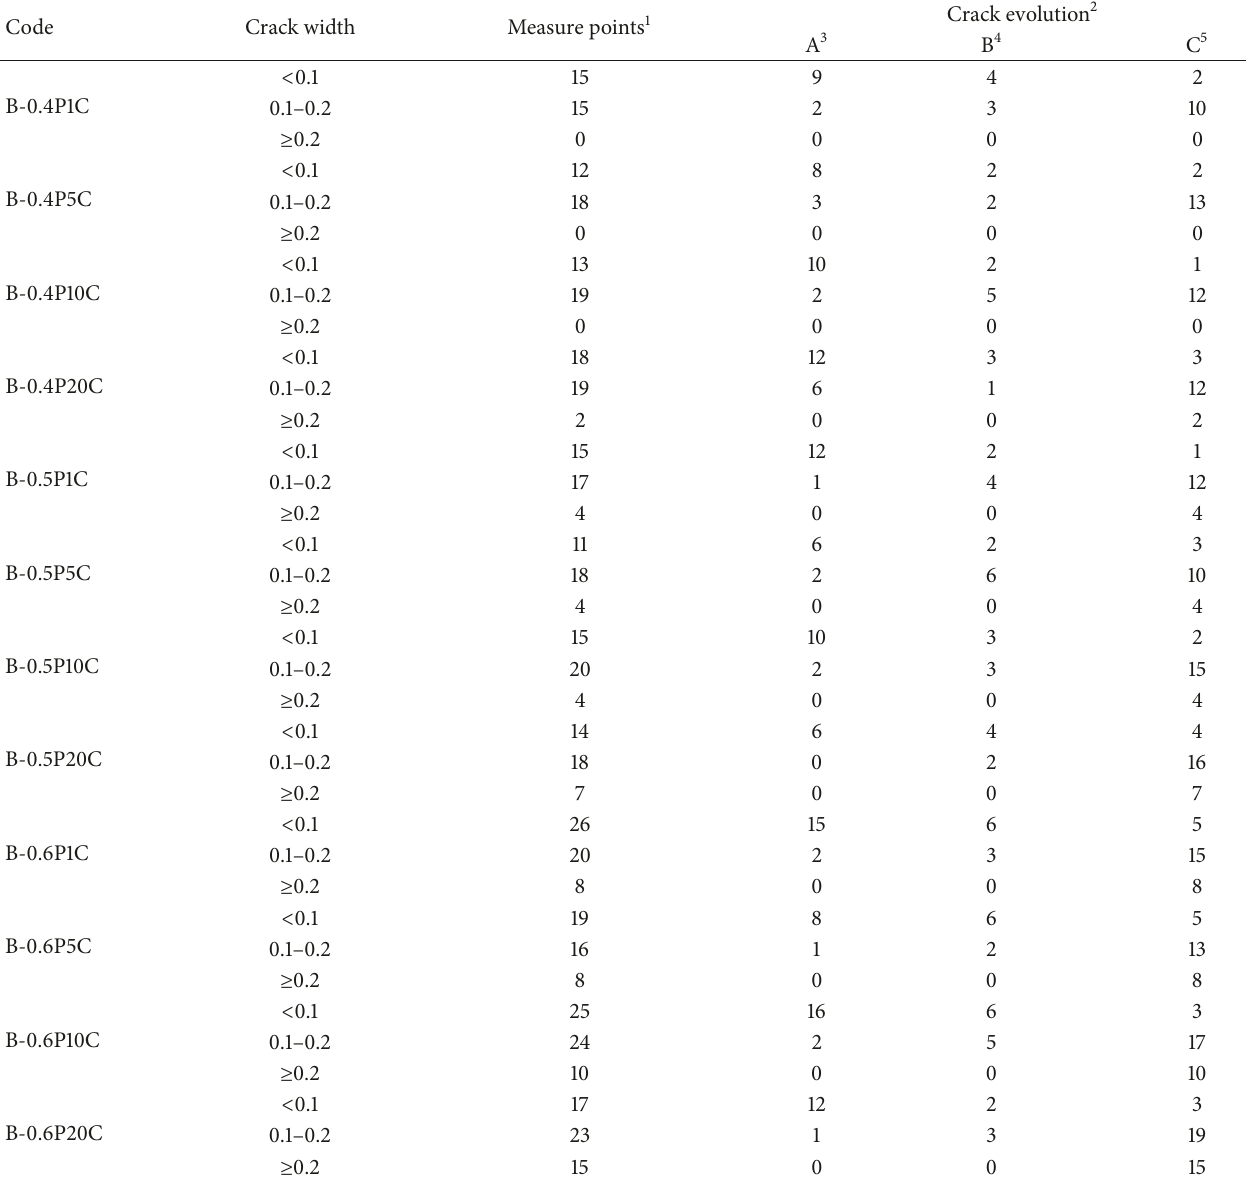
Table 7: Statistics of crack width variation before and after w-d